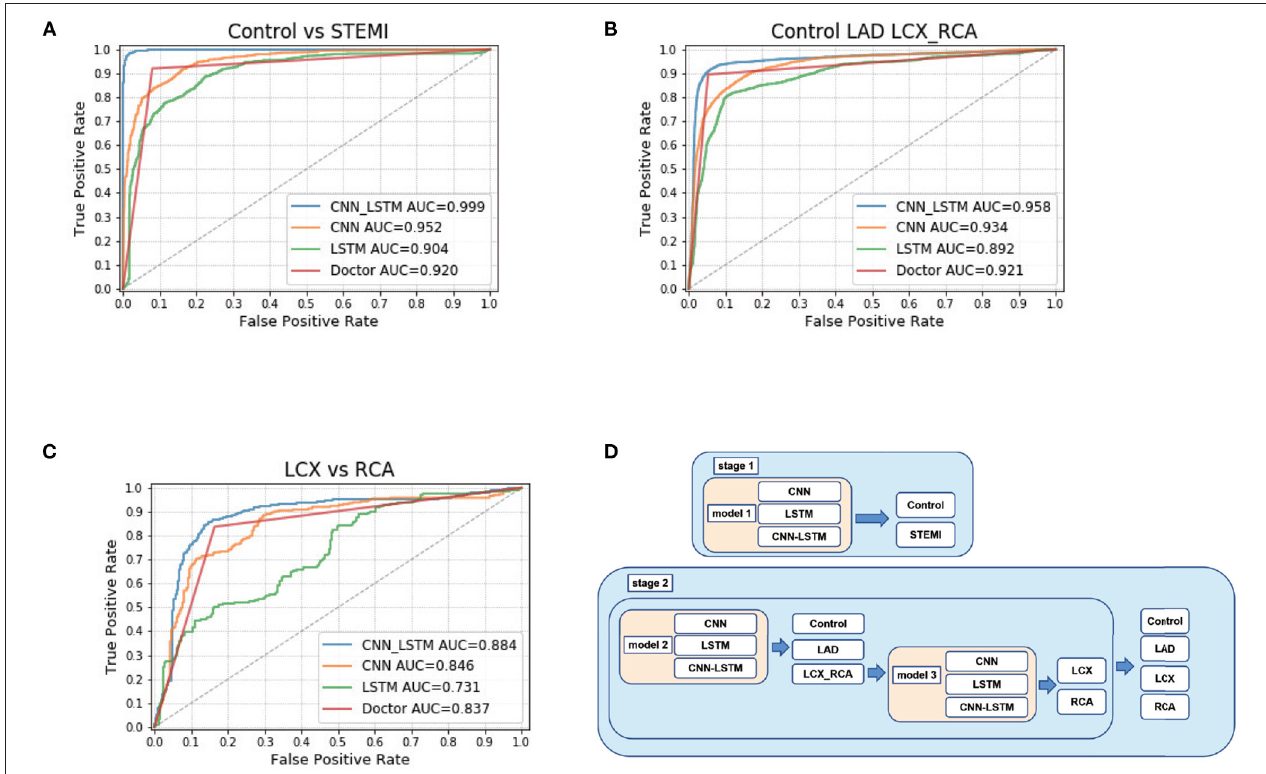
FIGURE 2 | CNN-LSTM achieved the highest accuracy among CNN, LSTM, CNN-LSTM, and doctors. (A) ROC curve calculated at the sequence level for control and STEMI in the Test 2 dataset. (B) ROC curve calculated at the sequence level for control, LAD, LCX, and RCA. (C) ROC curve calculated for LCX and RCA. (D) Schematic of deep learning